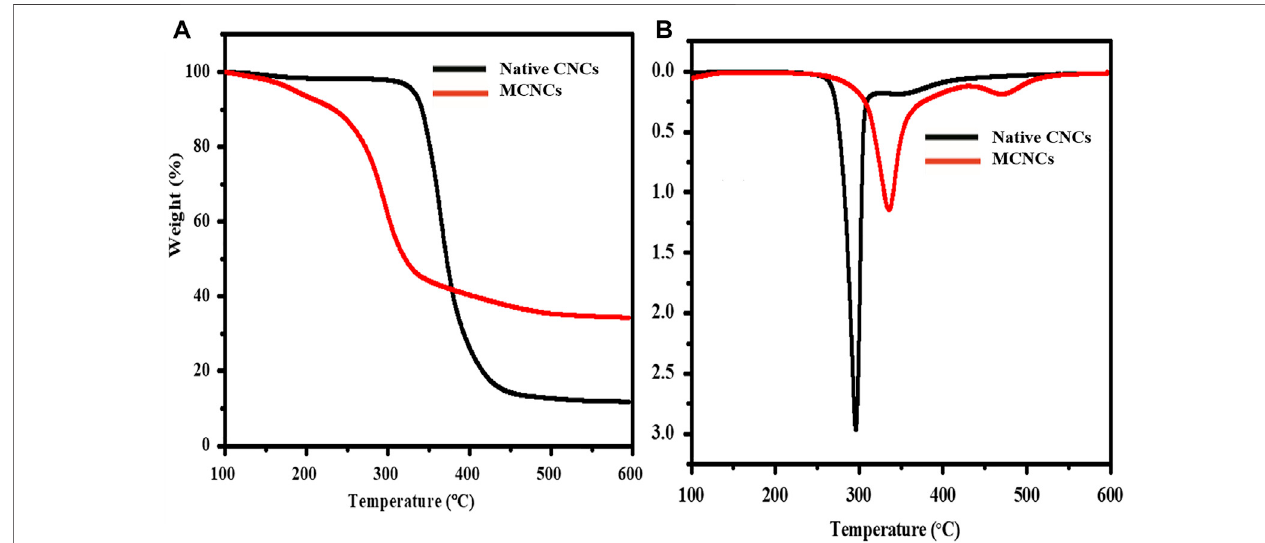
FIGURE 6 | (A) TGA and (B) DTG curves of native and modi fi ed CNCs.